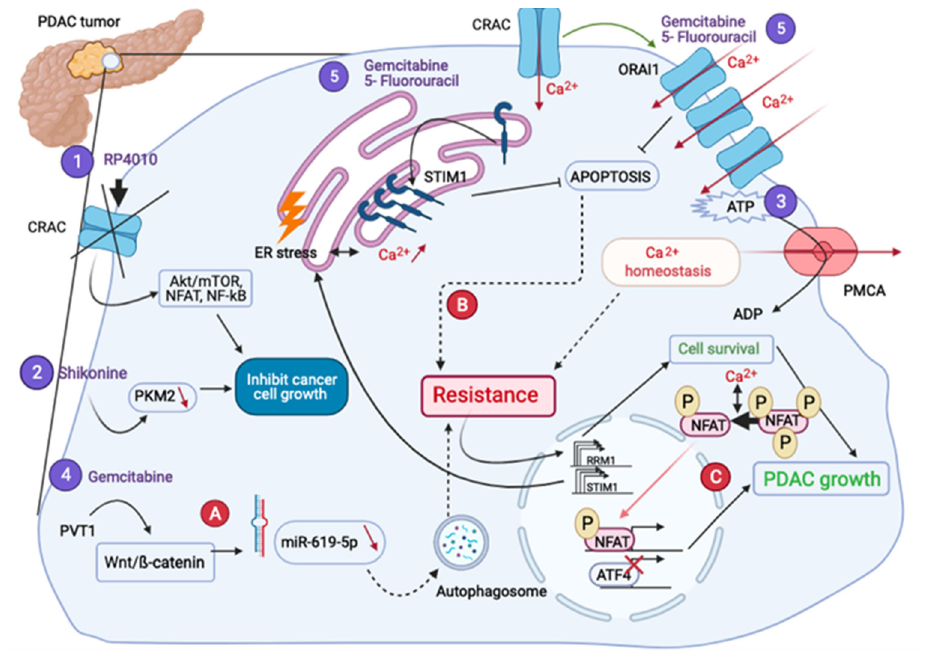
Figure 4. PDAC treatments and different therapeutic resistances. RP4010 (1) and Shikonine (2) treatments inhibit cell growth. The inhibition of the ATP used by the PMCA (3) decreases the proliferation rate. Gemcitabine combined treatments (4–5) leading to the chemoresistance, pass through the autophagic activity (A), and a decrease of the apoptosis (B), respectively. The resistance to Gemcitabine also leads both to the overexpression of RRM1 inducing cell survival and STIM1, activating the NFAT-dependent transcriptional program (C).